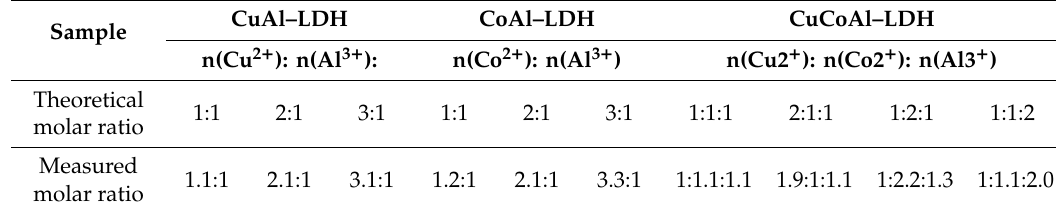
Table 1. The molar ratio of various metallic components measured by ICP–OES. CuAl–LDH CoAl–LDH CuCoAl–LDH Sample n(Cu 2 + ): n(Al 3 + ): Theoretical molar ratio